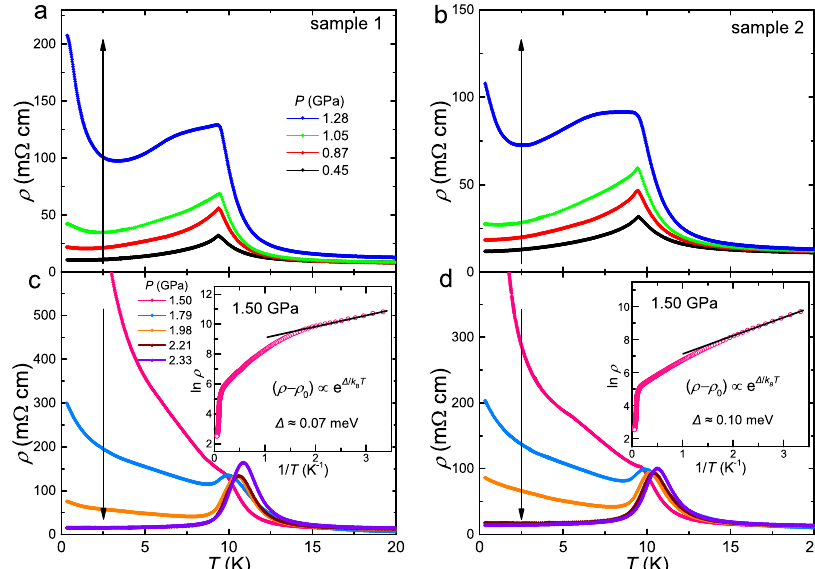
Fig. 2 Metallic-insulating-metallic evolution of electrical transport under applied pressure. Temperature dependence of the ab -plane resistivity ρ ( T ) of EuCd 2 As 2 under various pressures from 0.45 GPa to 1.28 GPa, for samples ( a ) #1 and ( b ) #2. The corresponding ρ ( T ) under pressures from 1.50 GPa to 2.21 GPa are shown in panels ( c ) and ( d ). The insets of ( c ) and ( d ) show ln ρ ð T Þ as a function of 1/ T at 1.50 GPa, and Þ / e Δ k ρ ð T Þ is linear in 1/ T (solid black lines). The vertical arrow in each panel fi ts to ð ρ ð T Þ (cid:2) ρ B T are performed at low temperatures, where ln 0 marks the direction of increasing